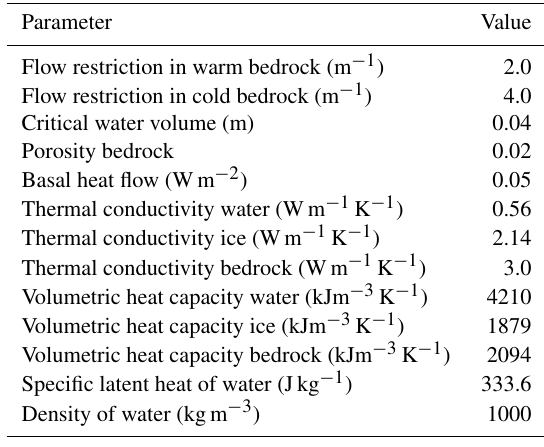
Table B1. Model parameters for the frost cracking model of Ander- sen et al. (2015) used and not already given in Sect. 3 of the main